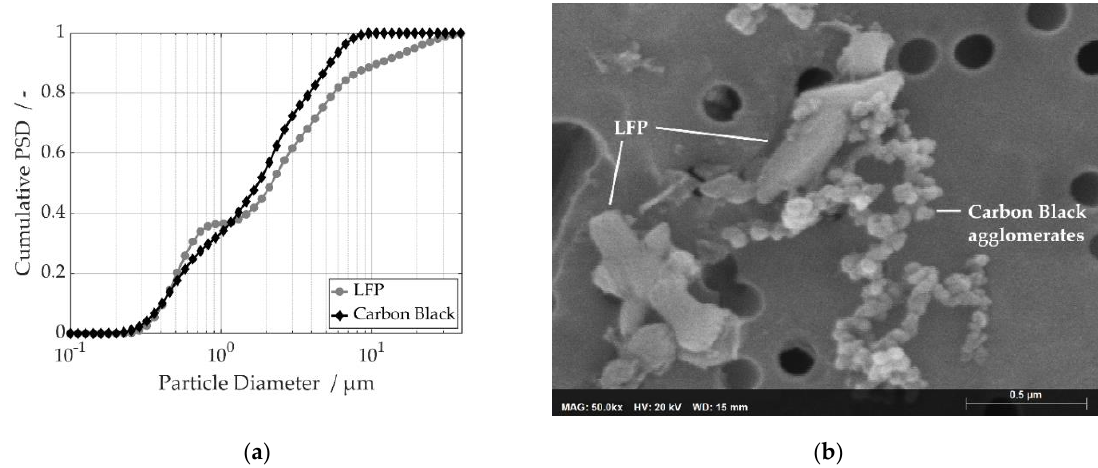
Figure 2. Particles in the feed dispersion. ( a ) Particle Size Distributions of LFP (grey) and Carbon Black (black) particles. ( b ) SEM image of LFP and Carbon Black particles on a nucleopore filter. An overview of the characteristic particle sizes 𝑥 10 , 𝑥 50 and 𝑥 90 , including mean values and standard deviations, as well as measured PSDs in detail (averaged) is displayed in Figure 3.